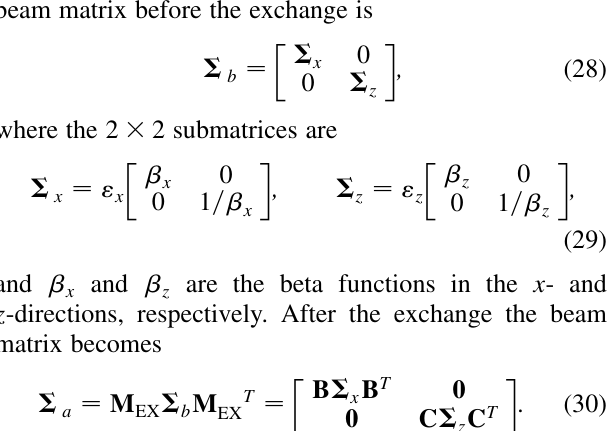
). The matrix for M and C D